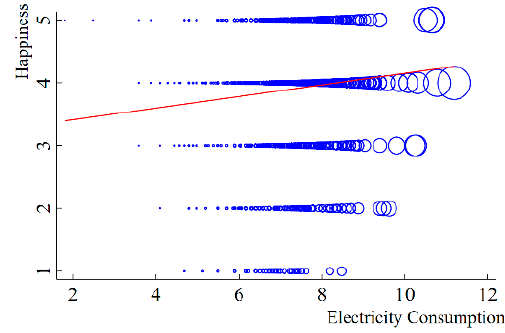
Figure 3. Happiness and electricity consumption.